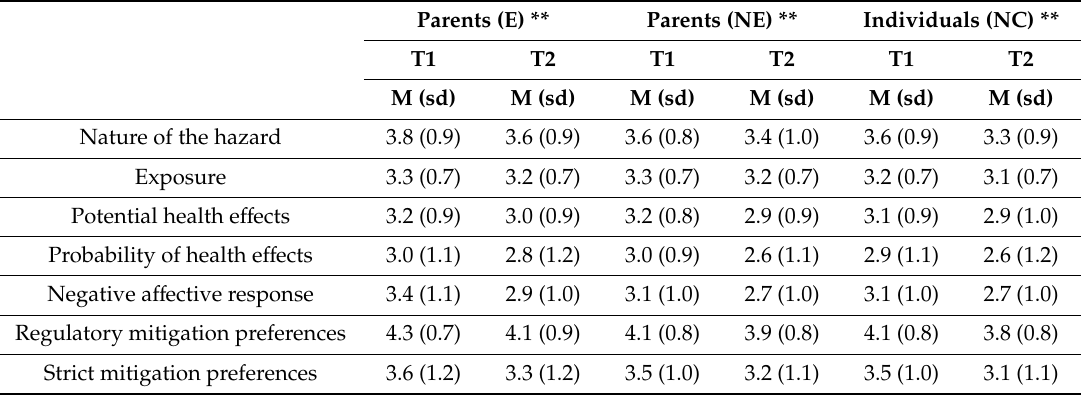
Table 3. Means and standard deviations of perceptions of risks related to rubber granulate and preferences for mitigation per group at T1 and T2